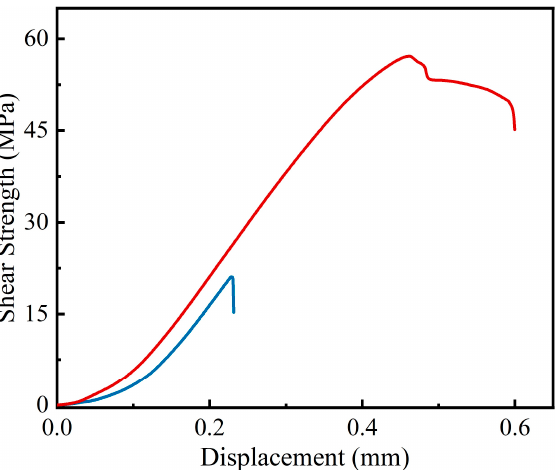
Figure 13. Two typical stress–displacement curves of the joints. Blue line: curve of Figure 12a, red line: curve of Figure 12b.